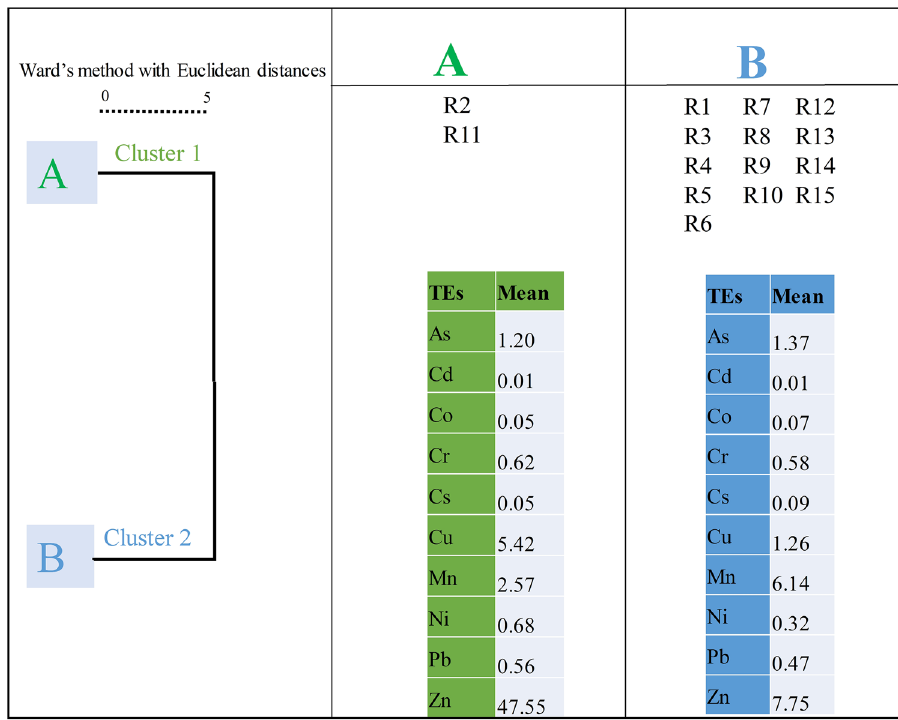
Fig. 4 Clustering of water sam- ples in dendrogram from the Rupa Lake, Gandaki Province, Nepal (concentration of the TEs are expressed in μg/L)